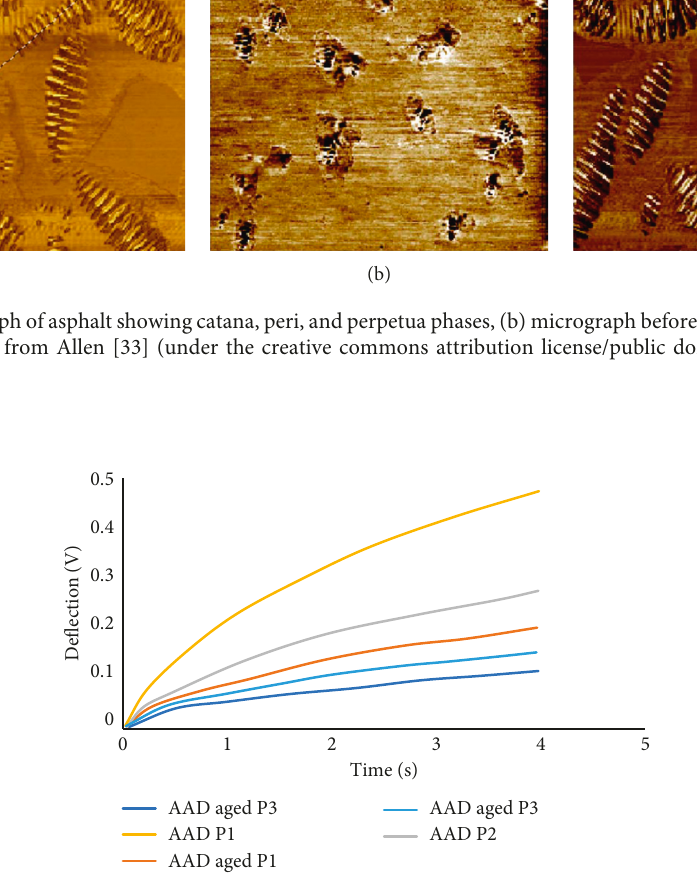
Figure 11: Effect of aging on asphalt phases. The figure is obtained from Allen et al. [33] (under the creative commons attribution license/ public domain).